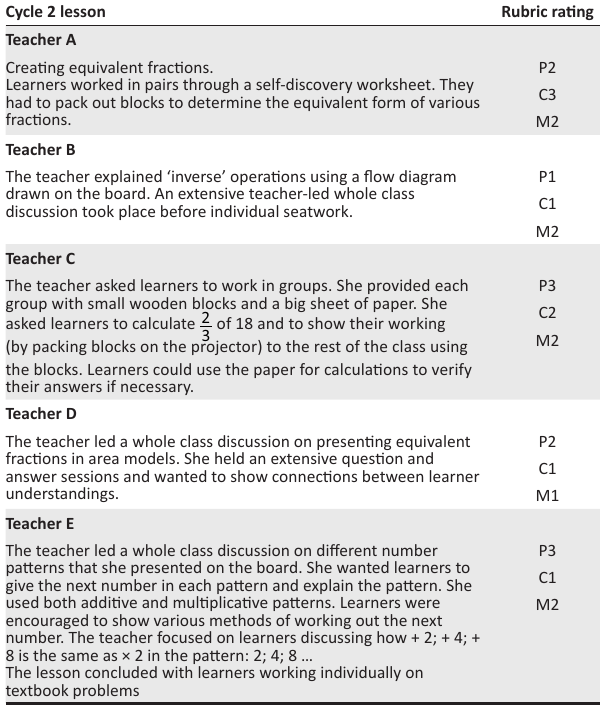
FIGURE 5: Example of card matching activity.